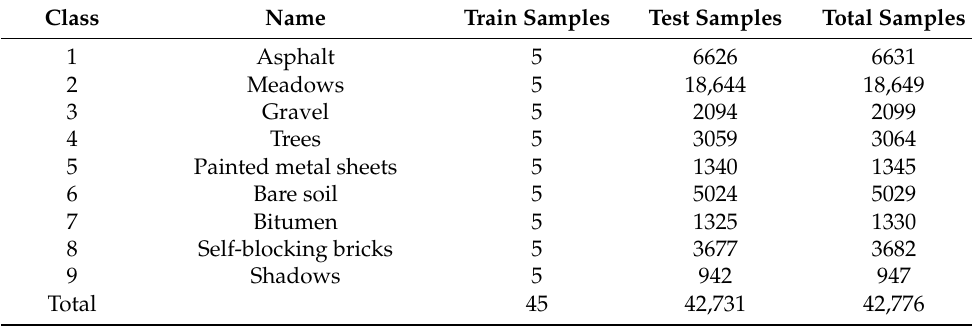
Table 2. The number of samples used for training and testing in the PU dataset.